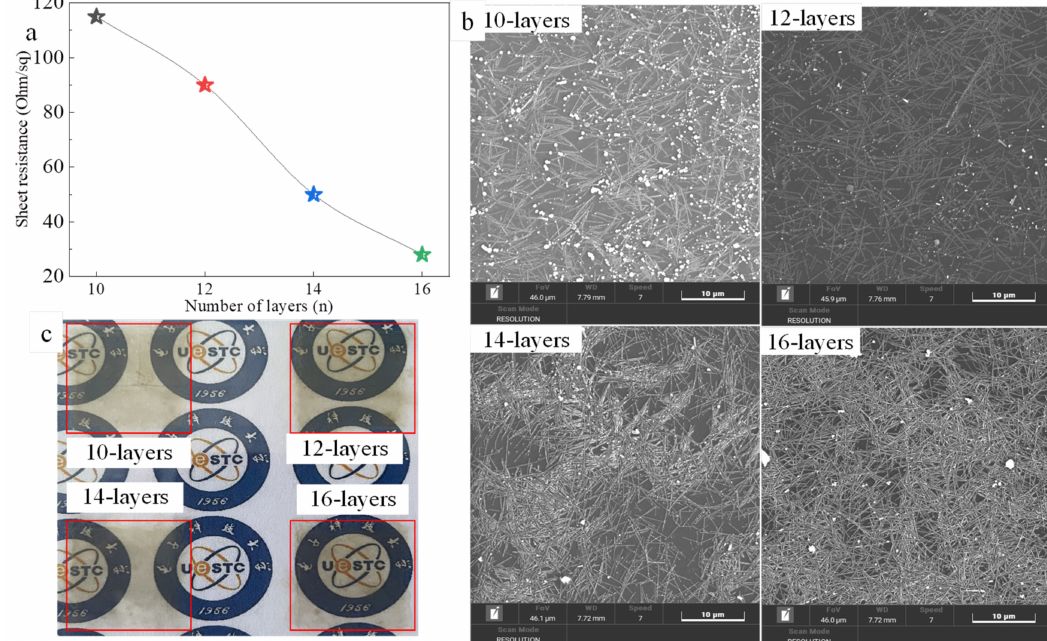
Figure 10. Sheet resistance ( a ) and SEM images ( b ) and photographs ( c ) of the AgNWs films with the printing layers of 10, 12, 14, and 16.